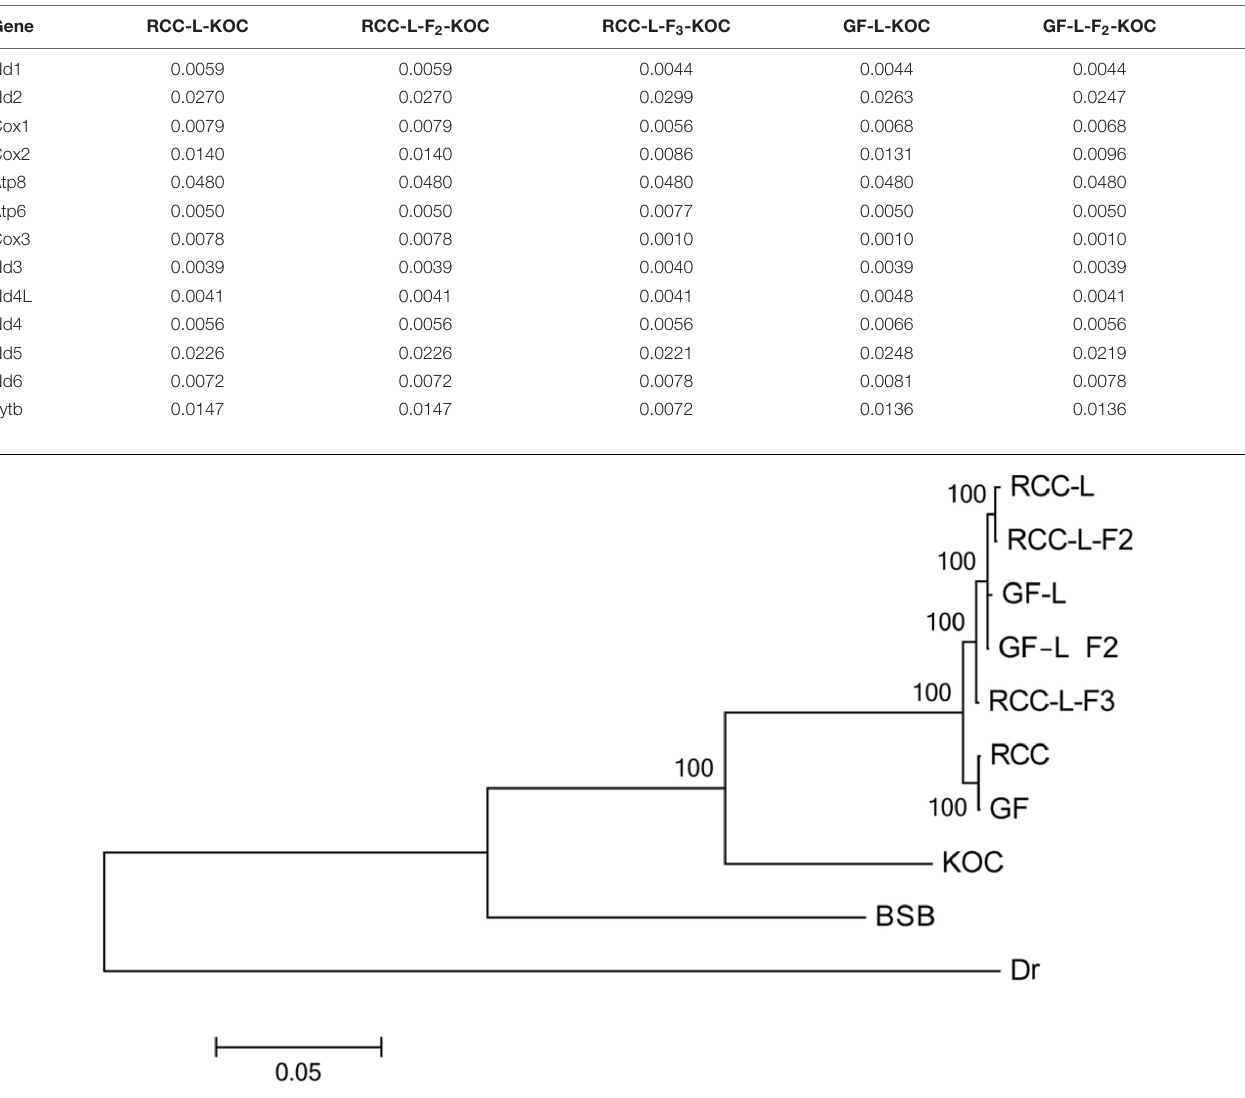
TABLE 4 | The dN/dS values between the F 1 hybrids, F 2 hybrids, F 3 hybrids, and their own female maternal parents (KOC).